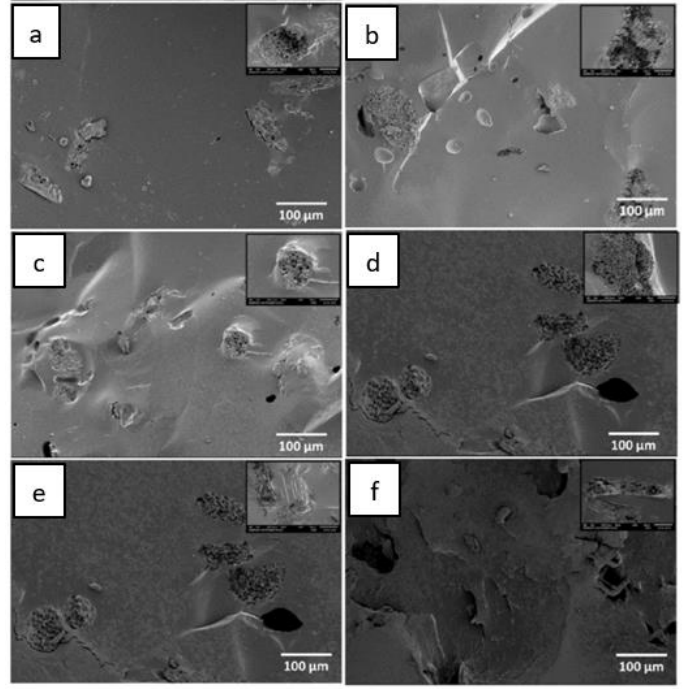
Figure 4. Micrography of ( a ) thermoplastic starch (TPS) 5% raw fibre, ( b ) TPS 5% alkali treated fibre, ( c ) TPS 10% raw fibre, ( d ) TPS 10% alkali treated fibre, ( e ) TPS 20% raw fibre, and ( f ) TPS 20% alkali treated fibre [6].